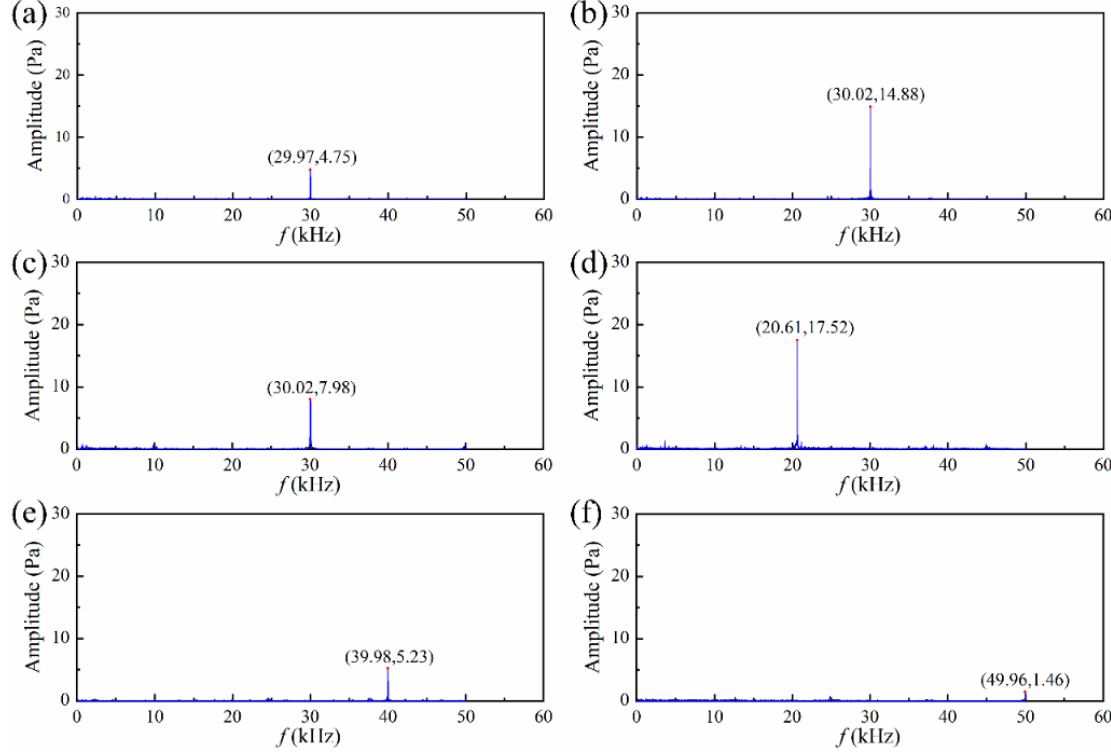
Figure 8. The frequency-domain images of the sound frequency of the FCA welding arc in